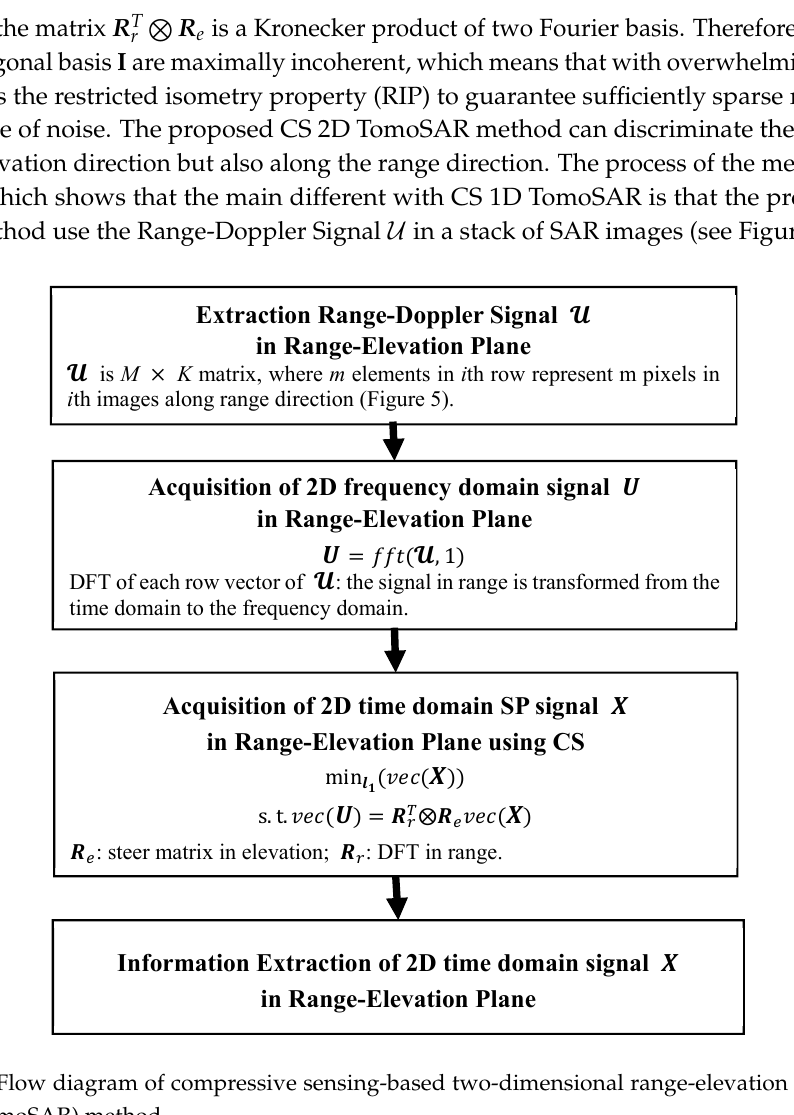
Figure 5. Range-Doppler Signal (cid:2335) in the range-elevation plane. 3. Datasets